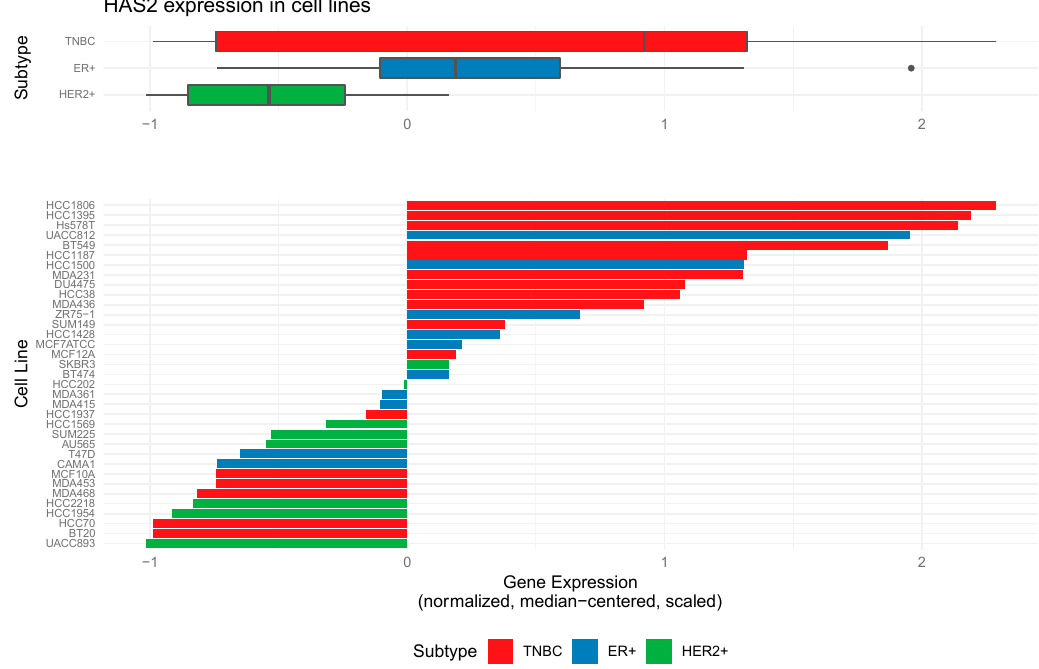
Figure 1. Hyaluronan synthase 2 expression ( HAS2 ) in human breast cancer cell lines is associated with the triple negative breast cancer (TNBC) subtype. Analysis of HAS2 transcript expression using the NanoString nCounter platform to assess gene expression levels within a panel of breast cancer cell lines that include estrogen receptor ER+, progesterone receptor PR+, human epidermal growth factor receptor 2 HER2+ and triple negative (TNBC) subtypes. Gene expression levels were compared between cell line subtypes using an analysis of variance (ANOVA) test using R software. The ANOVA indicated significant differences between groups ( p -value = 0.0395), prompting pairwise significance testing using the Tukey HSD post-test. A significant difference in HAS2 expression was found between TNBC vs. HER2+ subtypes ( p -value = 0.0307702). Note, HAS2 expression was elevated in 11/17 TNBC cell lines. Data are summarized in the horizontal box plots (median, first and third quartiles, and 1.5 * interquartile range values are displayed).